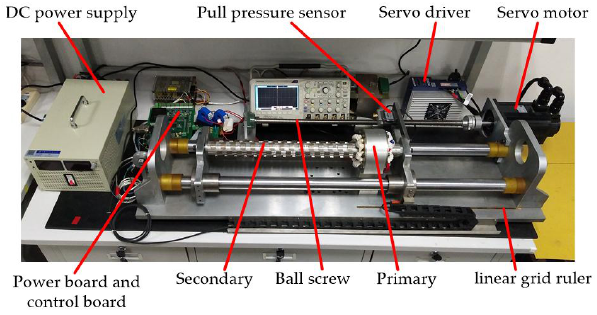
Figure 16. Experiment platform.